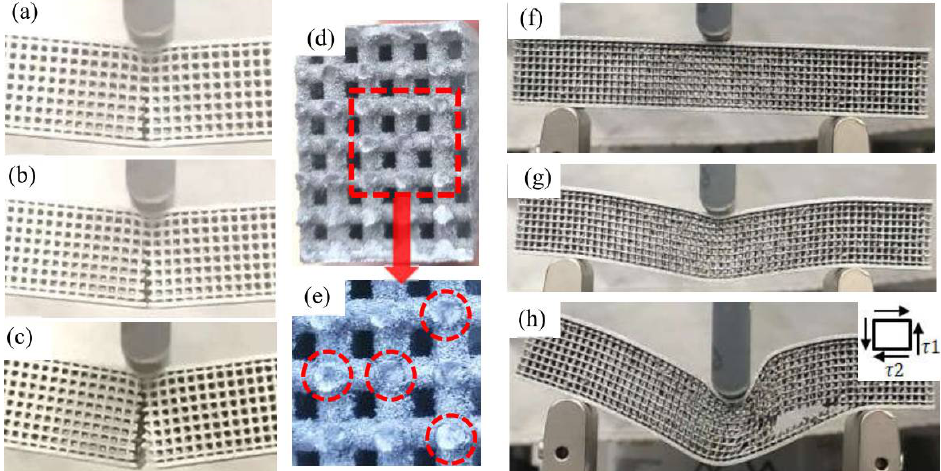
Figure 5. Bending process of samples. ( a ) initial stage of sample 2#–9#; ( b ) intermediate stage of sample 2#–9#; ( c ) late stage of sample 2#–9#; ( d ) fracture surface of sample 2#–9#; ( e ) enlarged view of the fracture surface; ( f ) initial stage of sample 1#; ( g ) intermediate stage of sample 1#; ( h ) late stage of sample 1#.